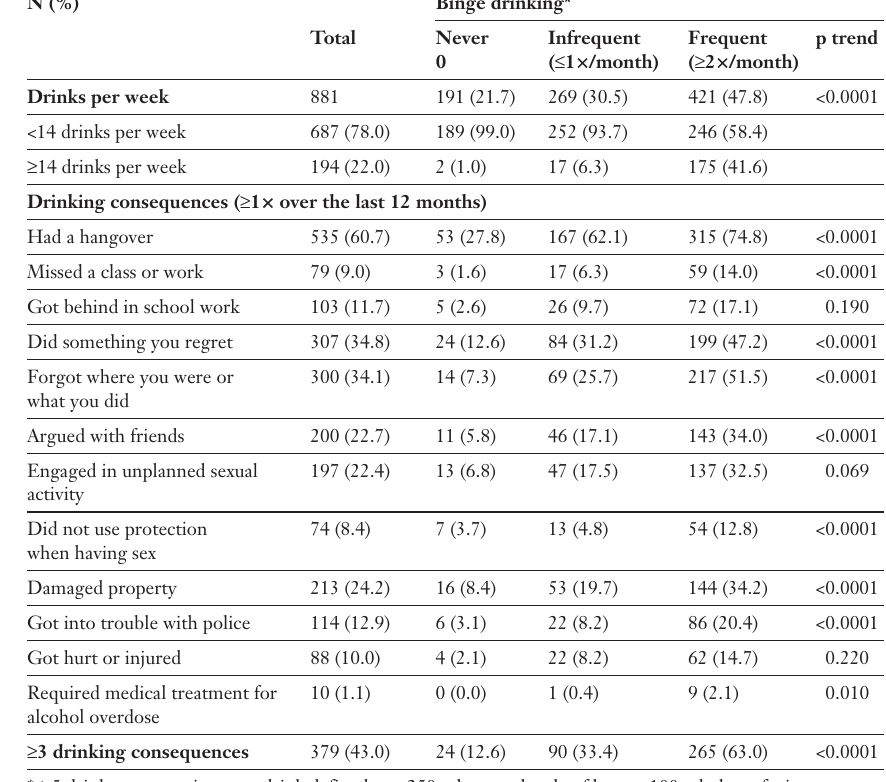
Alcohol use and drinking conse- quences according to binge drinking frequency in 881 young men.